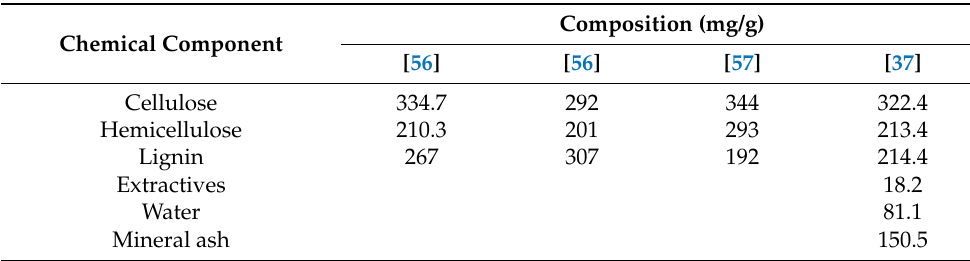
Table 2. Chemical constituents of rice husk (the composition of the mineral ash obtained after pyrolysis is reported in Table 3) (modified from [37,56,57]).